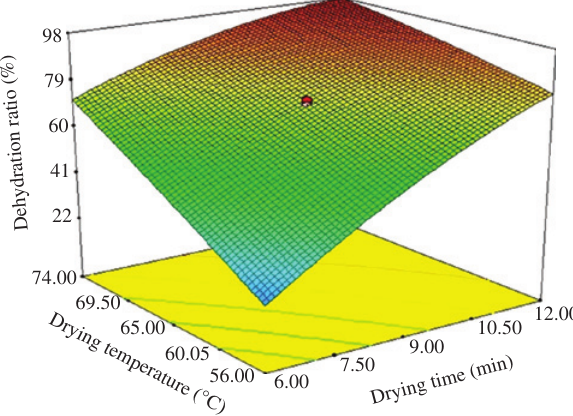
Figure 4: Interactive effect of drying temperature and time on dehydration ratio.